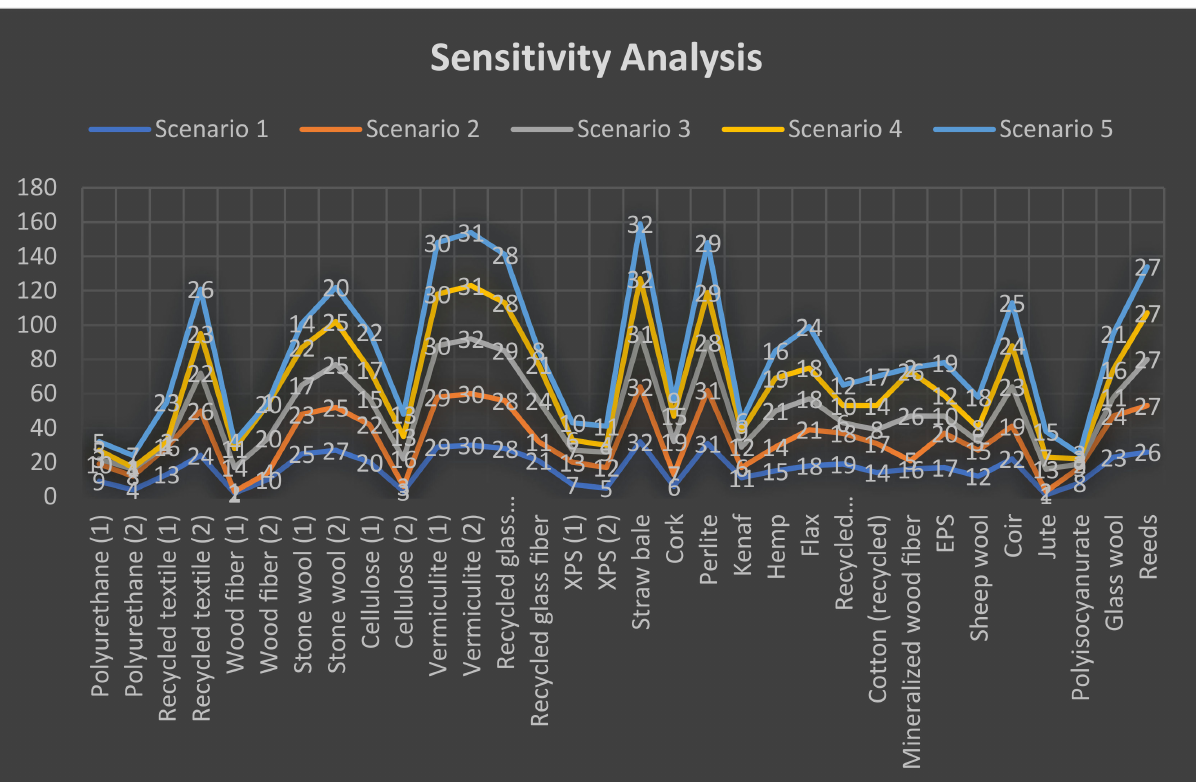
Figure 1. The results of